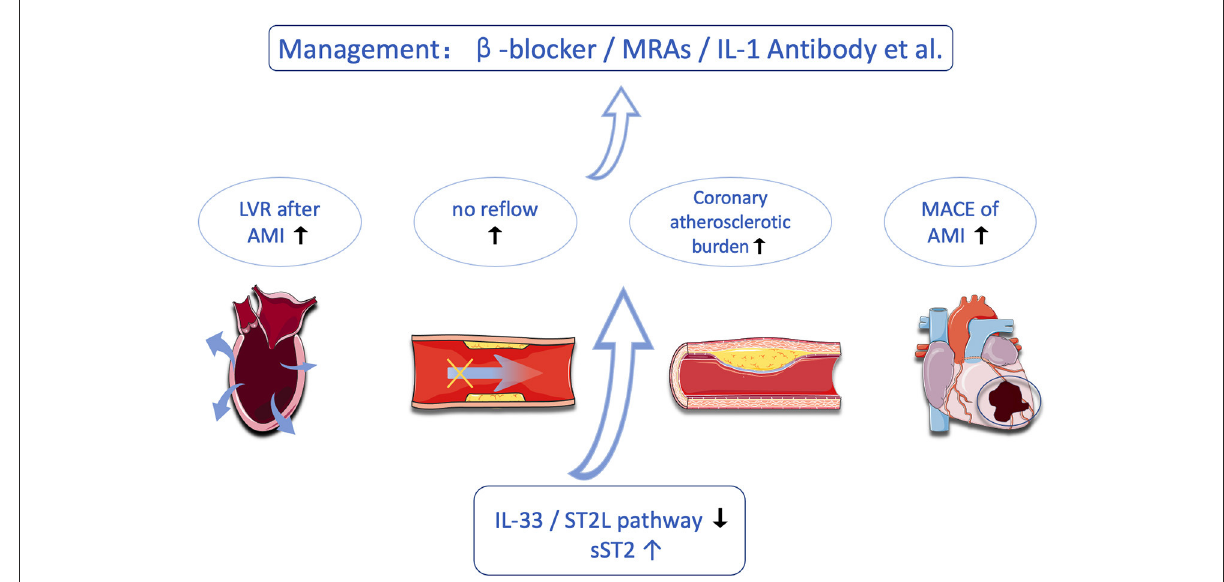
FIGURE2 Research progress on sST2 in the field of coronary heart disease.